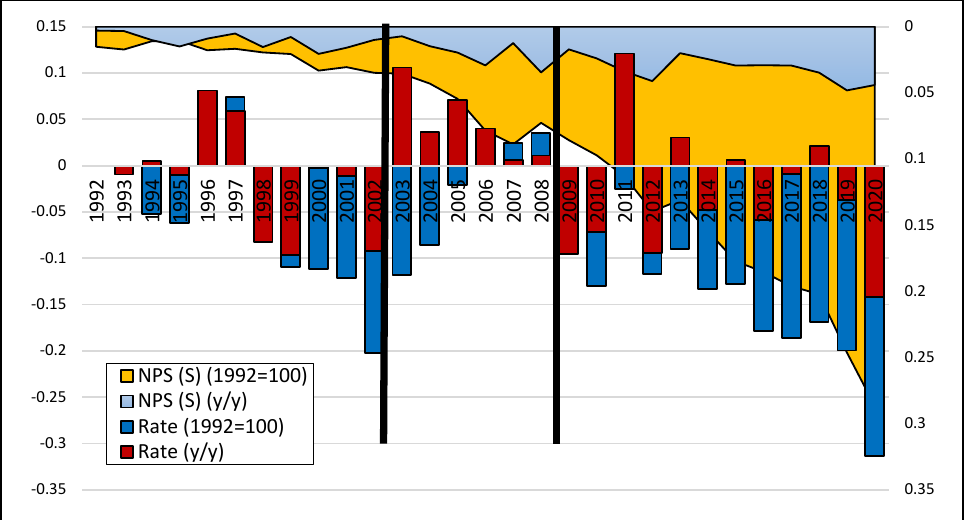
Figure 11. The rate of changes in the sales of steam coal volume, and the variability of changes in the structure of electricity generation in Poland (NPS 1992 = 100, NPS y/y) in 1992–2020. Source: as in Figure 10.